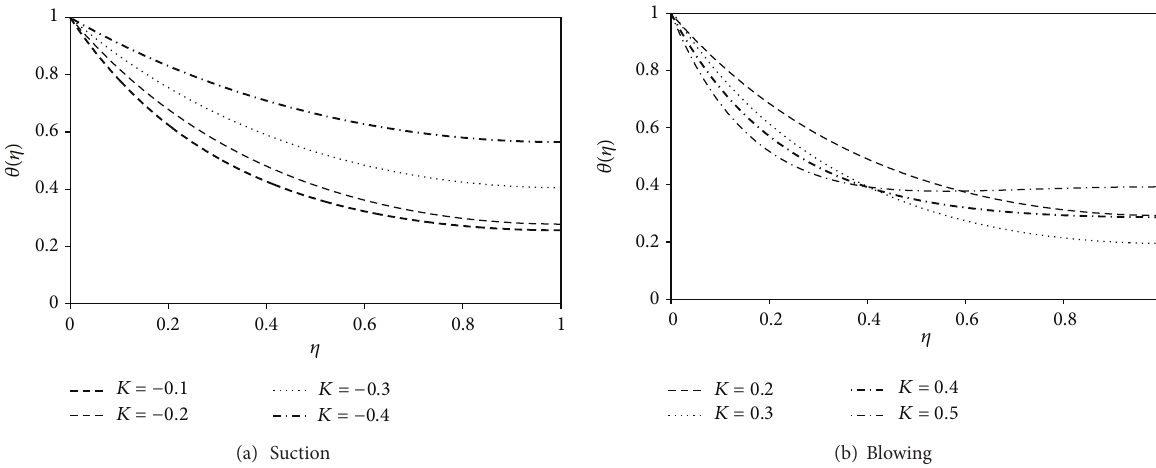
Figure 6: The effect of permeability parameter 𝐾 on the temperature distributions 𝜃(𝜂) using 10th-order HAM approximation when Pr = 1 .